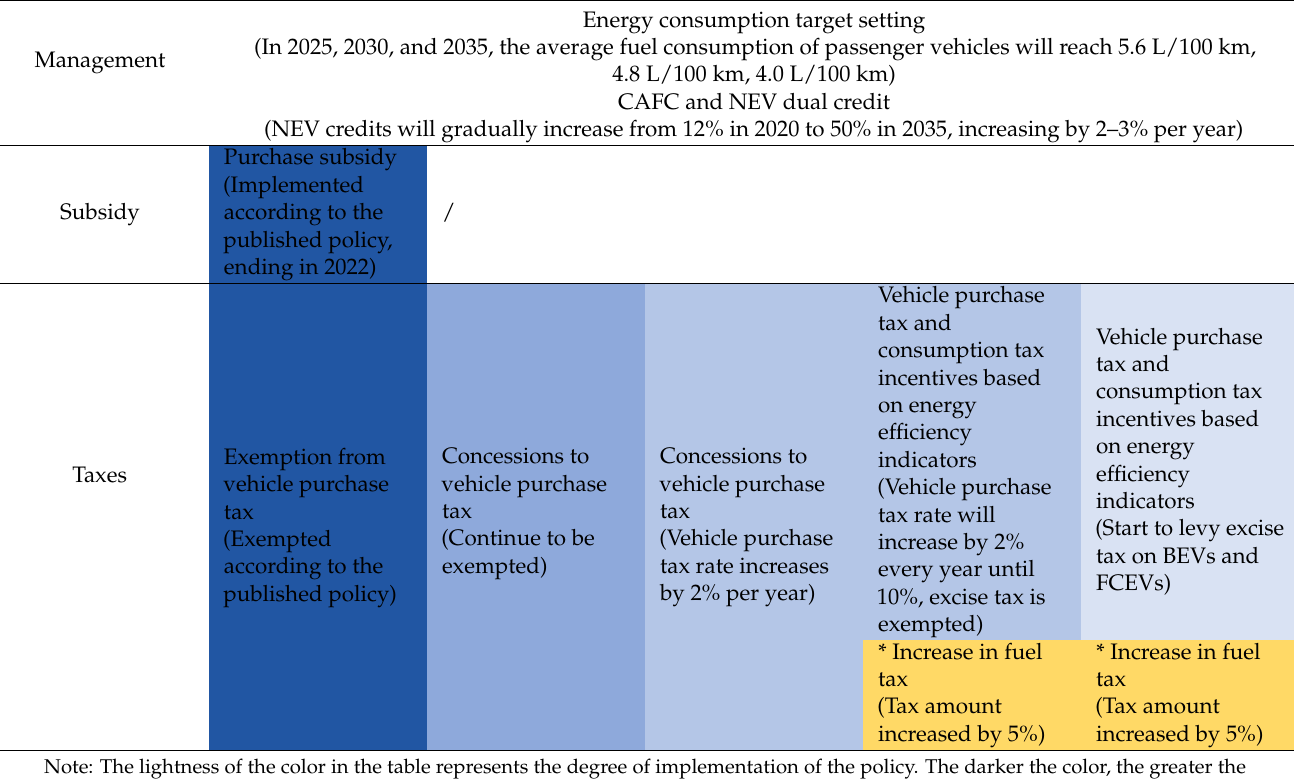
Table 3. Automotive industry-related policies and future scenarios that may be mainly considered in the model. Policy Category